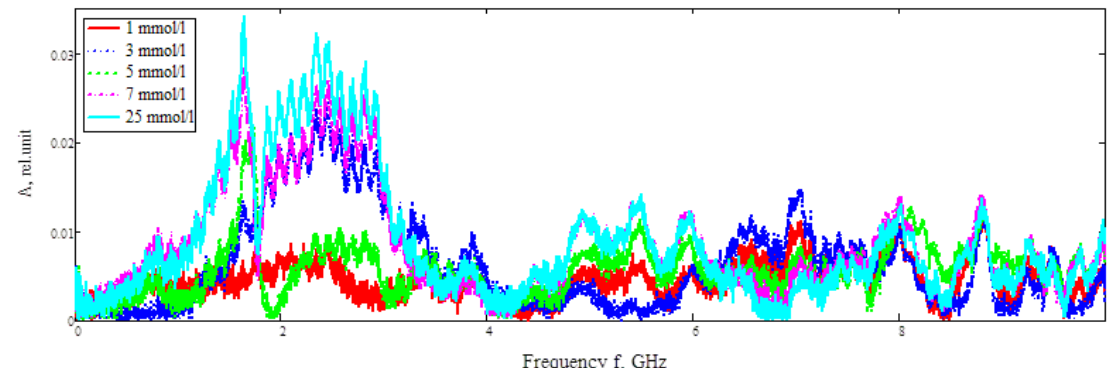
Figure 5. Dependence of the modulus of the complex reflection coefficient on the indicated dextrose concentrations in the entire measuring frequency range.